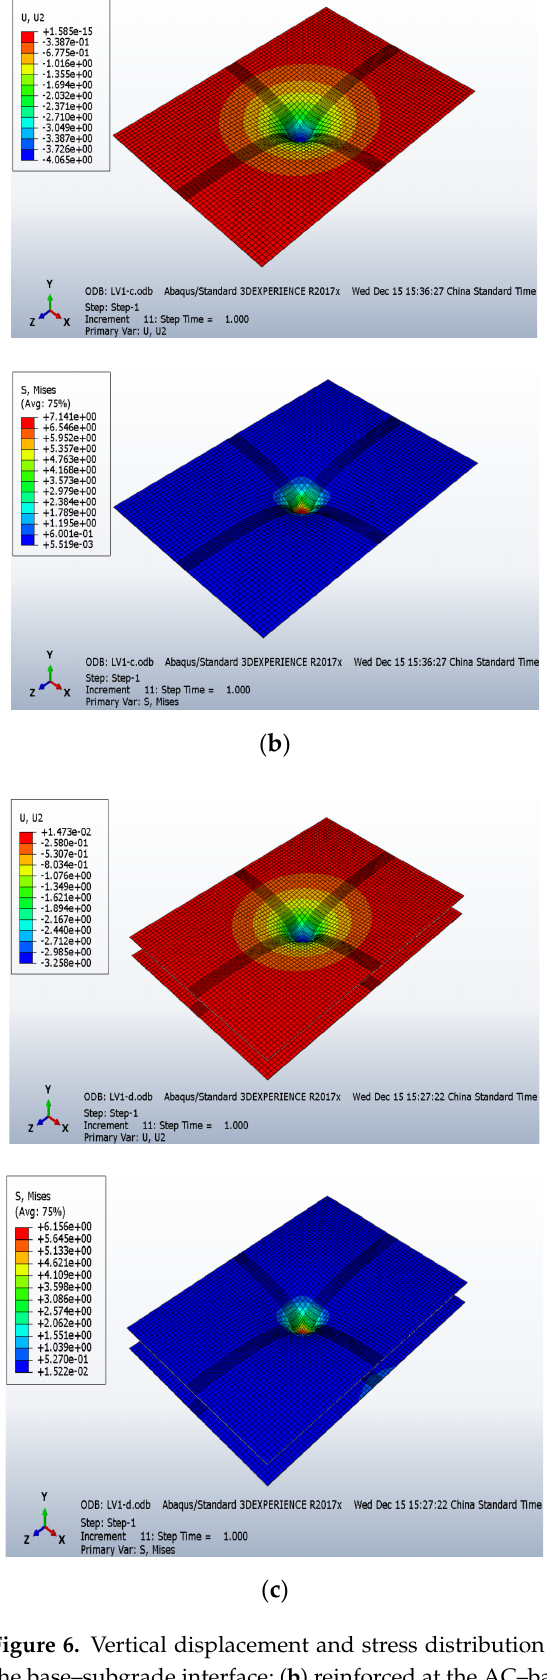
Figure 6. Vertical displacement and stress distribution in the geotextile’s plane: ( a ) reinforced at the base–subgrade interface; ( b ) reinforced at the AC–base interface; and ( c ) reinforced at the base–subgrade and AC–base interfaces.